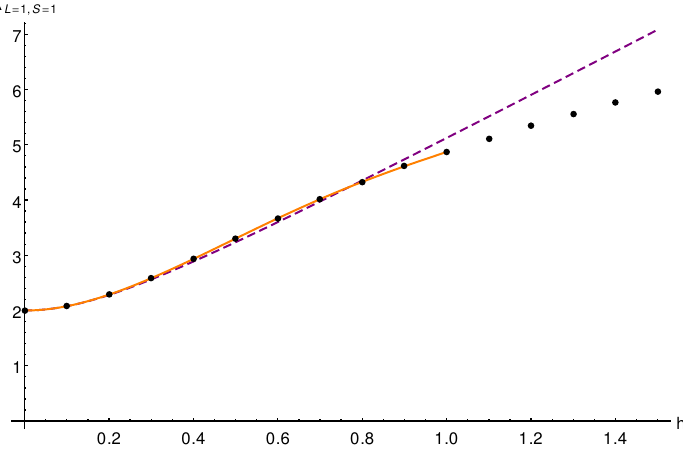
Figure 4 . Plot of (cid:1) L =1 ;S =1 ( h ) for h 2 (0 ; 1 : 5): the dots correspond to our numerical data, the dashed line represents the all-loop ABA expression (4.7) and the solid line interpolates the TBA results of [53]. For a plot in a wider range of h , see (cid:12)gure